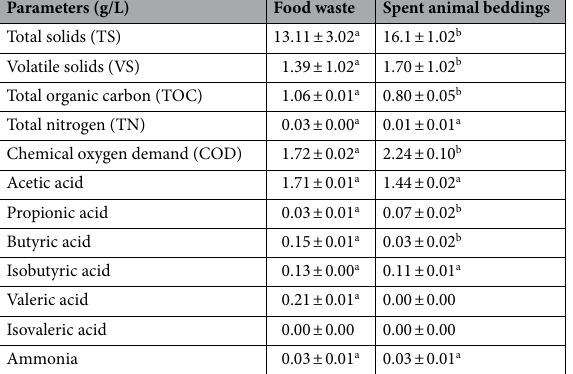
Table 4. Characteristics of effluent from food waste and spent animal beddings treatment in fuel cells (second phase). Values shown in table are means of triplicate analyses with respective standard errors; superscripts with same letters are statistically the same by the Tukey’s test at 5%.